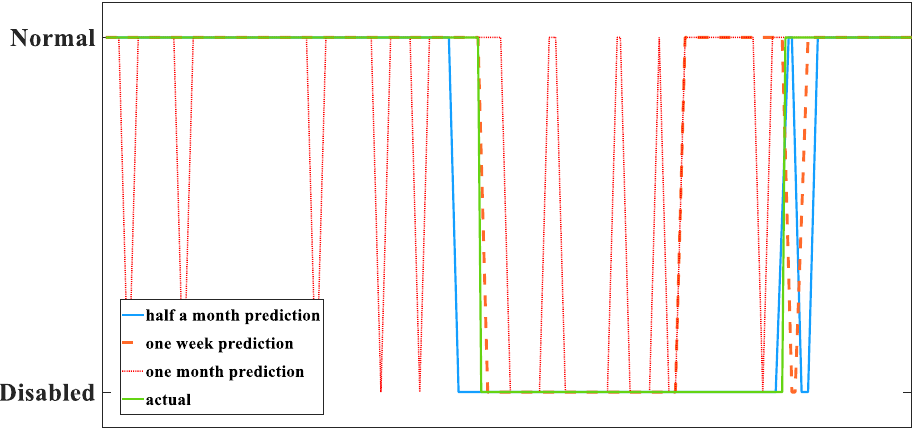
Figure 9. Comparison of predicted and actual conditions of TBM disc cutters from 6 to 12 June 2016.